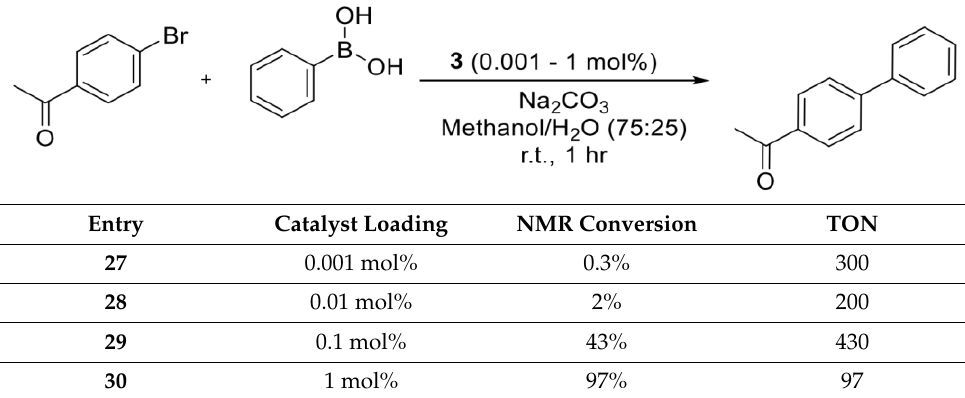
Table 4. Results from the catalytic loading screen with NMR conversion and calculated TON from the conversion.